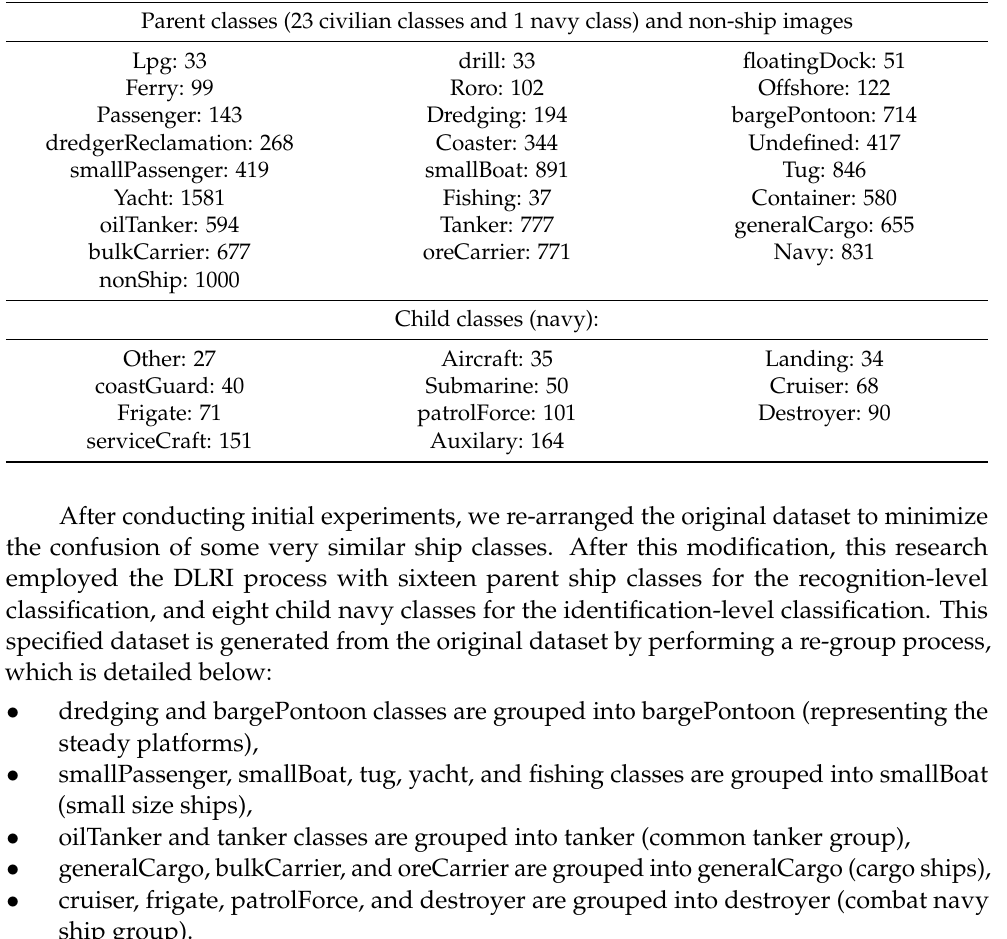
Table 3. VHRShips dataset class distribution. Class Distribution-Number of Ships Parent classes (23 civilian classes and 1 navy class) and non-ship images